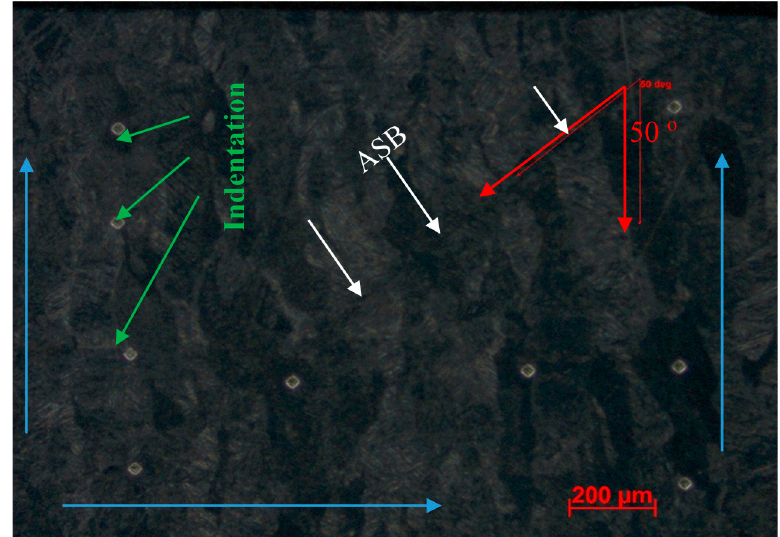
Figure 3. Illustration of typical indentations made on the cut surfaces of the specimens. The blue and red arrows show the direction of indentation and inclination of adiabatic shear bands (ASB), respectively.